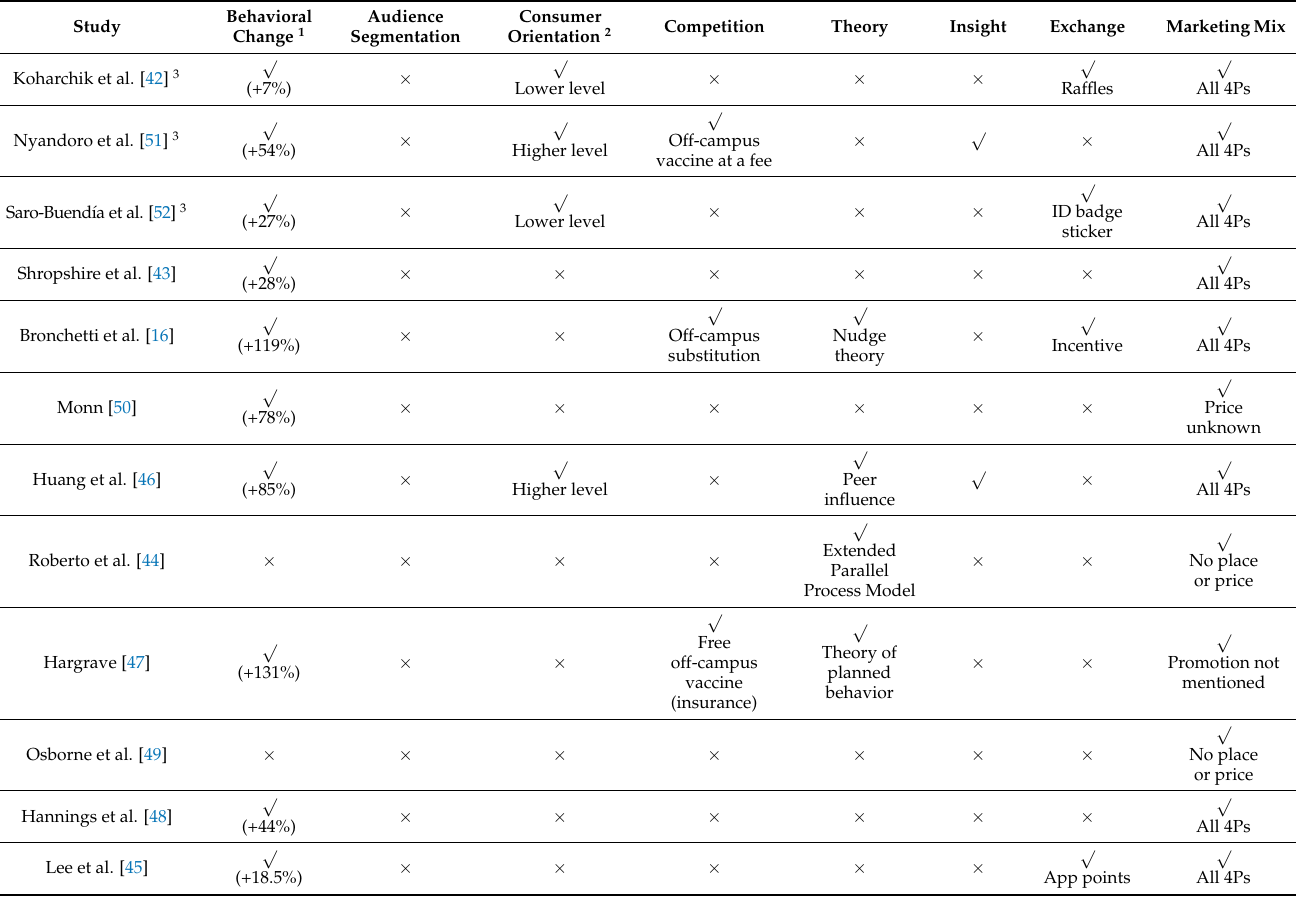
Table 3. Program assessment against social marketing